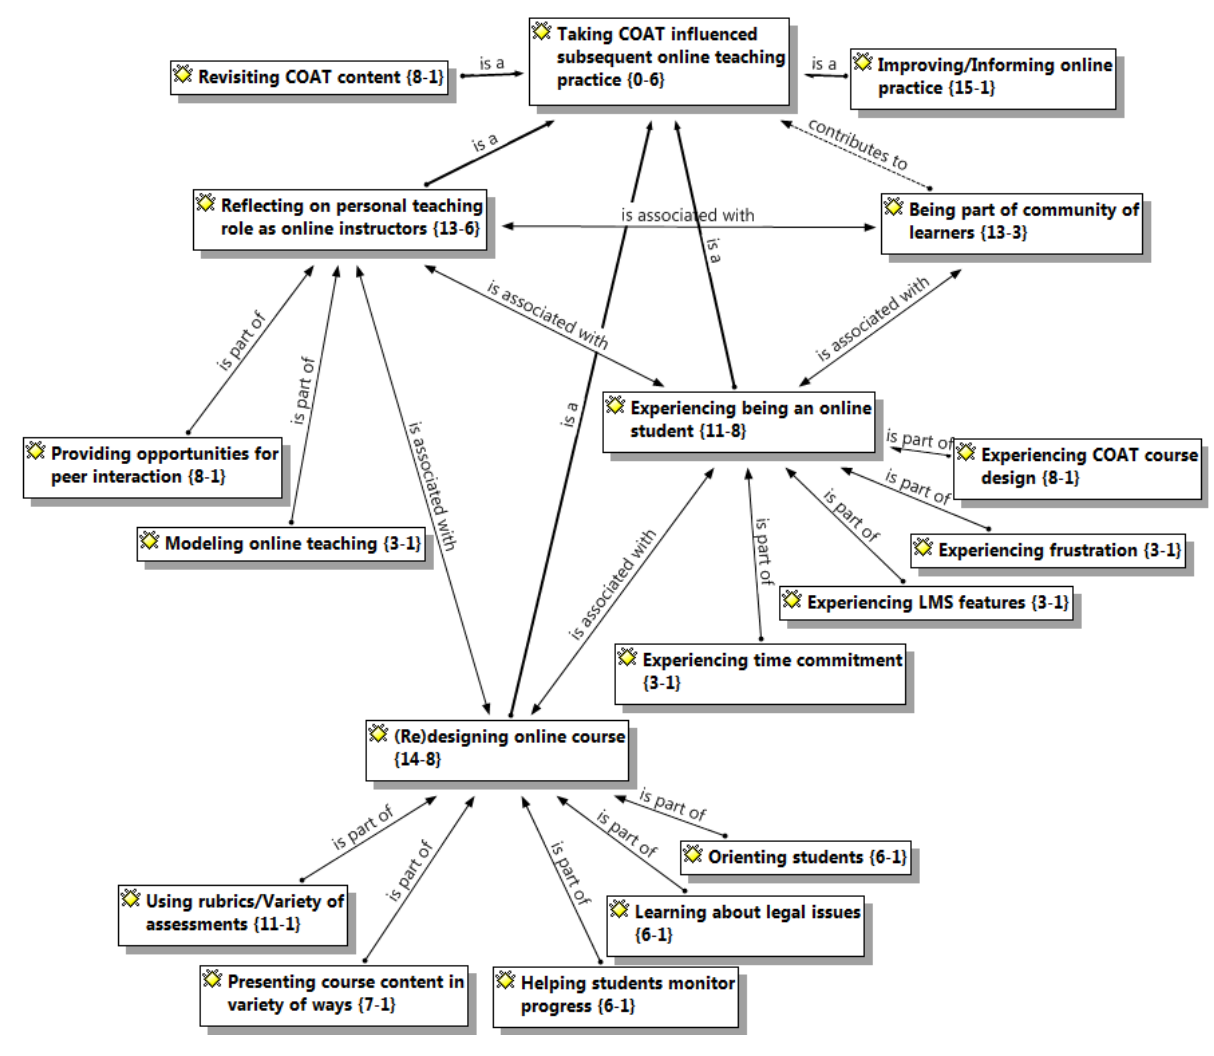
Figure 1. Concept map of responses to ways in which taking COAT influenced subsequent online teaching